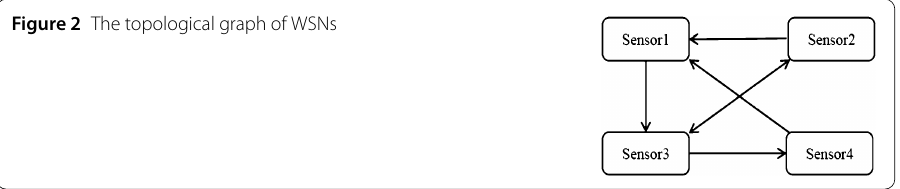
Figure 2 The topological graph of